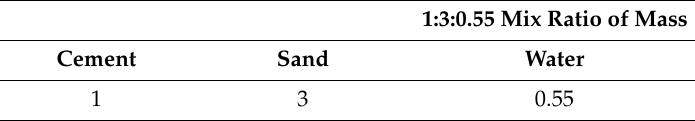
Table 4. Mix Ratio 2 used for mortars (TX10